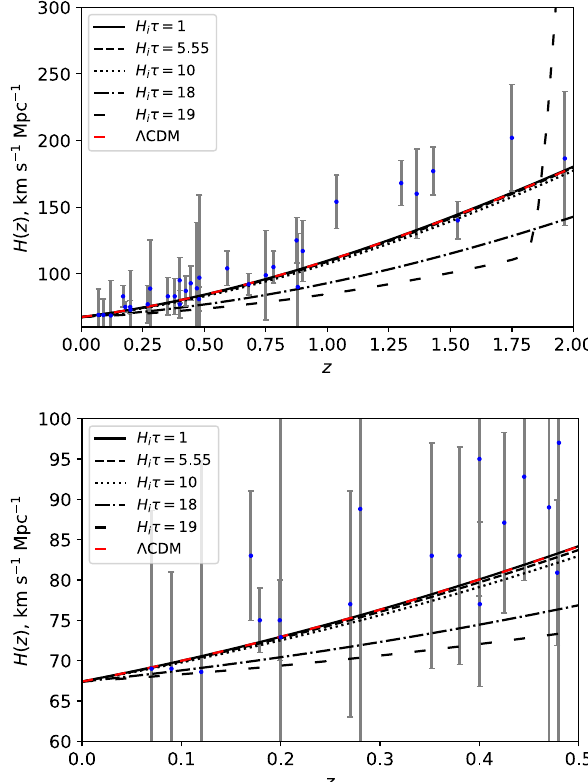
Fig. 6 The evolution of the Hubble expansion rate H ( z ) in units of km s − 1 Mpc − 1 at small and intermediate redshifts. Time-delayed cosmol- ogy closely follows Λ CDM even for delays on the order of H i τ ∼ 10. The Hubble data are taken from the compilation in Ref. [45]